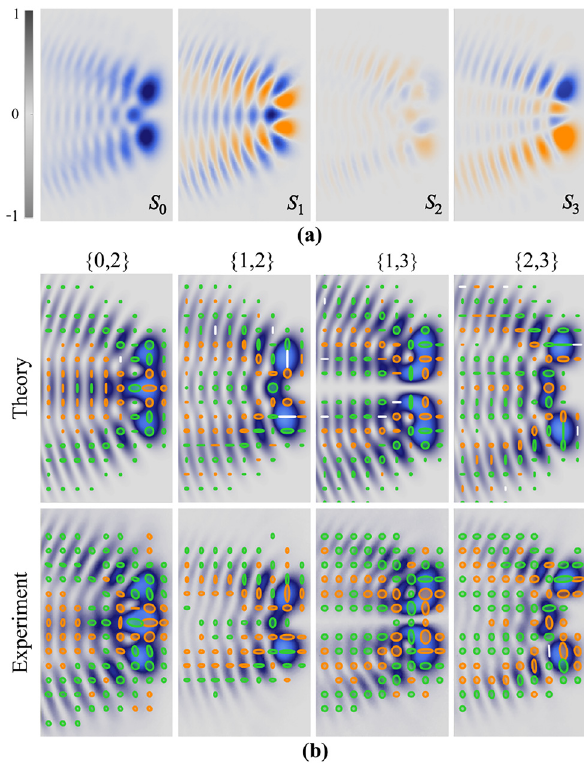
( 𝜂,𝜉, z ) (triangles) and 1 , 2 ( 𝜂,𝜉, z ) at three 1 , 2